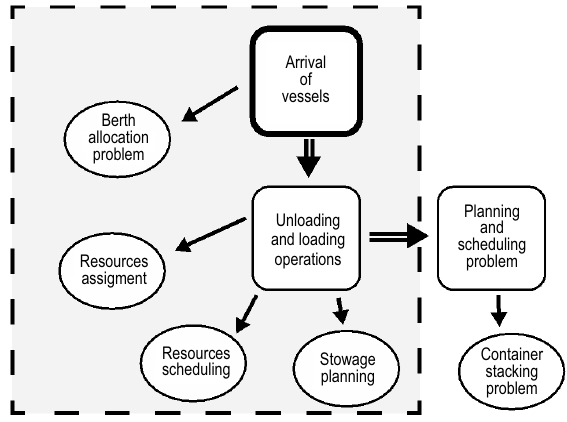
Fig. 1. Main planning and scheduling